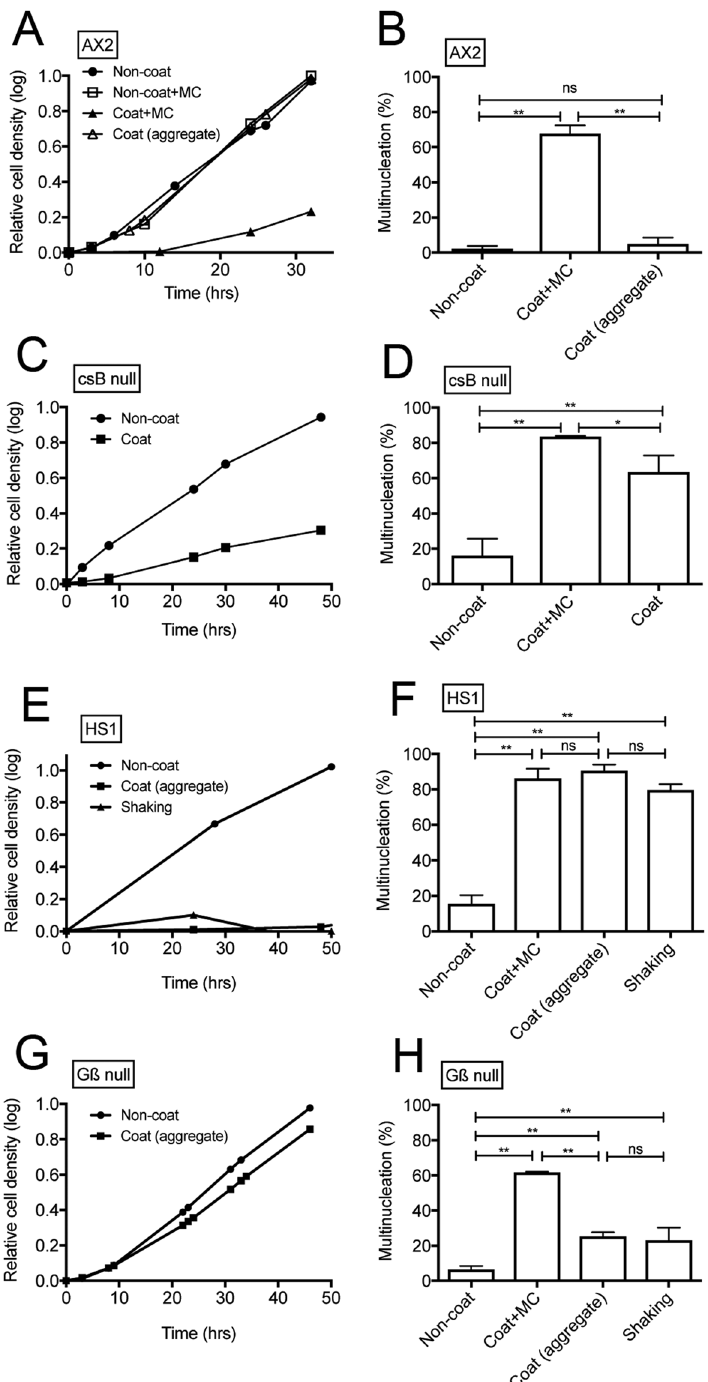
Figure 3. Cell growth and multinucleation of mutant cells in different culture conditions. ( A ) Cell growth of wild-type cells in the presence (closed triangles) and absence of methyl cellulose (MC, open triangles) in a Lipidure-coated dish. The growth of wild-type cells in the presence (open rectangles) and absence of MC (closed circles) in the non-coated dish was also plotted. Because the cells gradually formed aggregates even in the presence of MC, the formed aggregates were dispersed into single cells by pipetting every 5 h. ( B ) Frequency of multinucleation of wild-type cells (AX2) in different conditions: in a non-coated dish, in a coated dish containing MC, and in a coated dish (the cells formed multicellular aggregates). ( C ) Cell growth of csB- triple-mutant cells under different conditions, specifically in non-coated (closed circles) and coated (closed squares) dishes. ( D ) Frequency of multinucleation of csB-triple-mutant cells in different conditions: in a non- coated dish, in a coated dish containing MC, and in a coated dish. ( E ) Growth curves of myosin II-null cells at different culture conditions: in a non-coated dish (closed circles), in a coated dish (the cells formed multicellular aggregates, closed squares), and in shaking culture (closed triangles). ( F ) Frequency of multinucleation